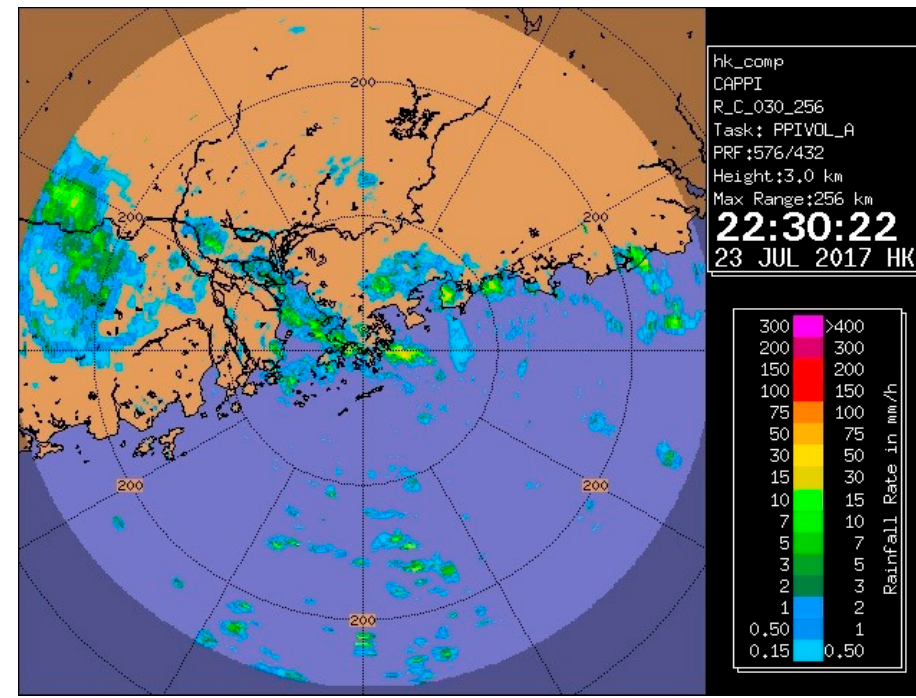
Figure 13. Radar imagery at 22:30 h on 23 July 2017.